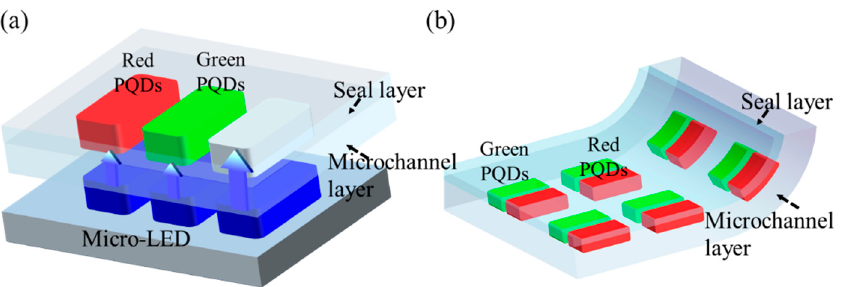
Figure 1. Schematic diagram of ( a ) a full-color micro-LED array display device and ( b ) the bending of the